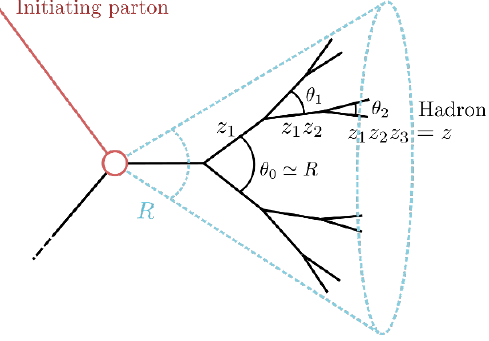
Figure 3 . The parton shower picture for fragmentation in a jet. At LL accuracy the splittings are strongly ordered in angle, causing the shower tree and clustering tree of the jet algorithm to